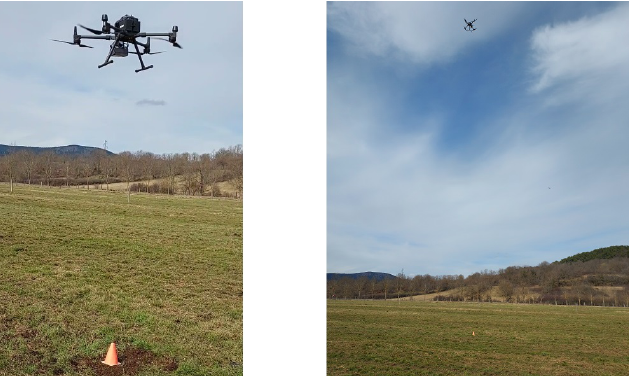
Figure 14. The UAV flying above the buried sensor